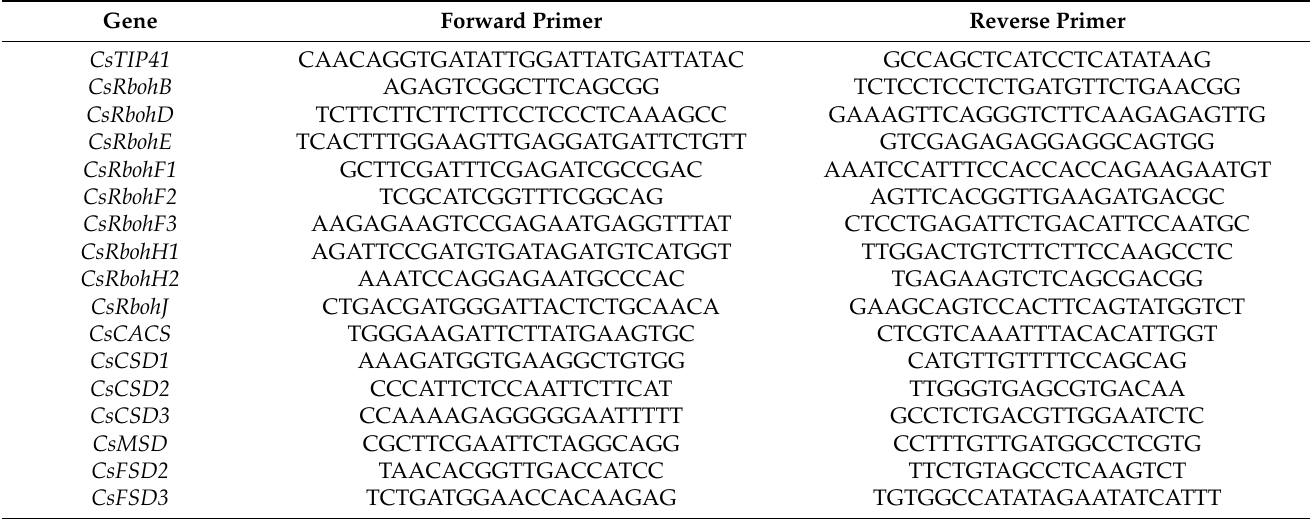
Table 1. The list of primers used in qRT-PCR